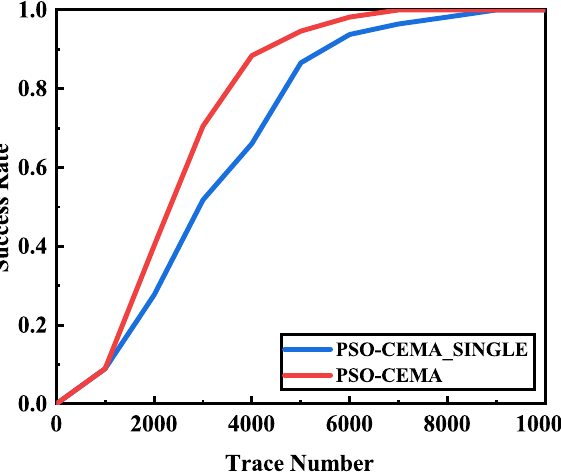
Figure 8. Success rate comparison of single byte and multiple bytes, the red line is multiple bytes optimized by PSO, and the blue line is a single byte optimized by